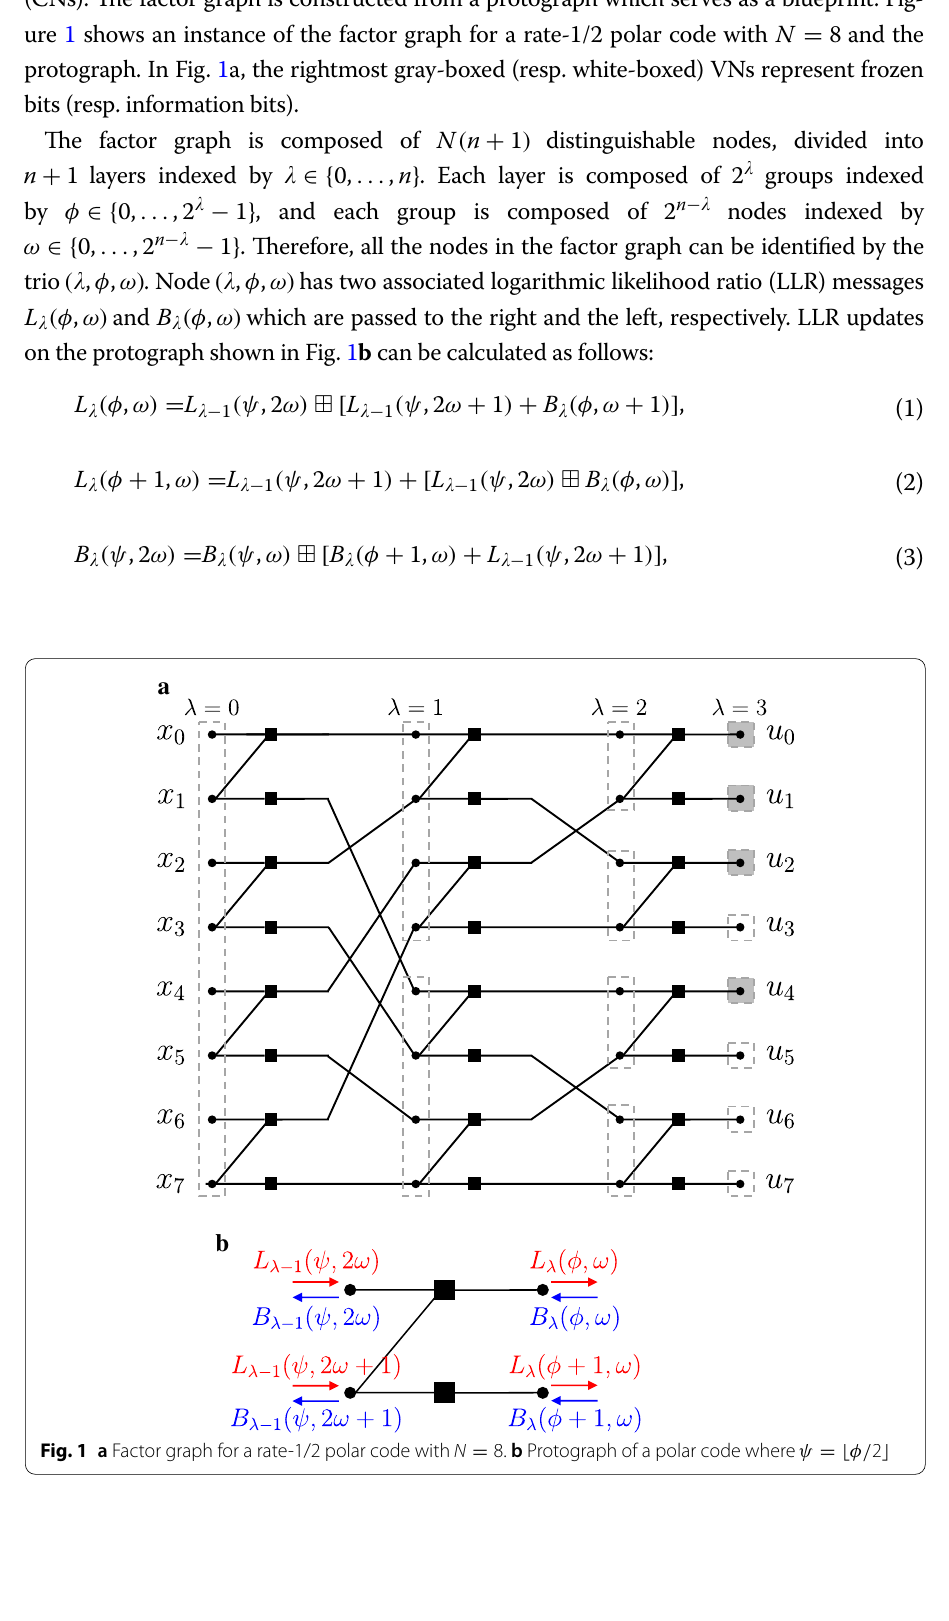
Fig. 1 a Factor graph for a rate‑1/2 polar code with N